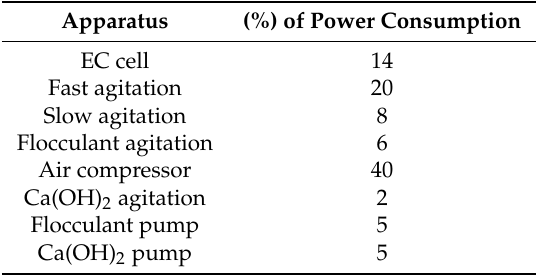
Table 7. Power consumption for particular items in the container unit ((%) of total power consumption).